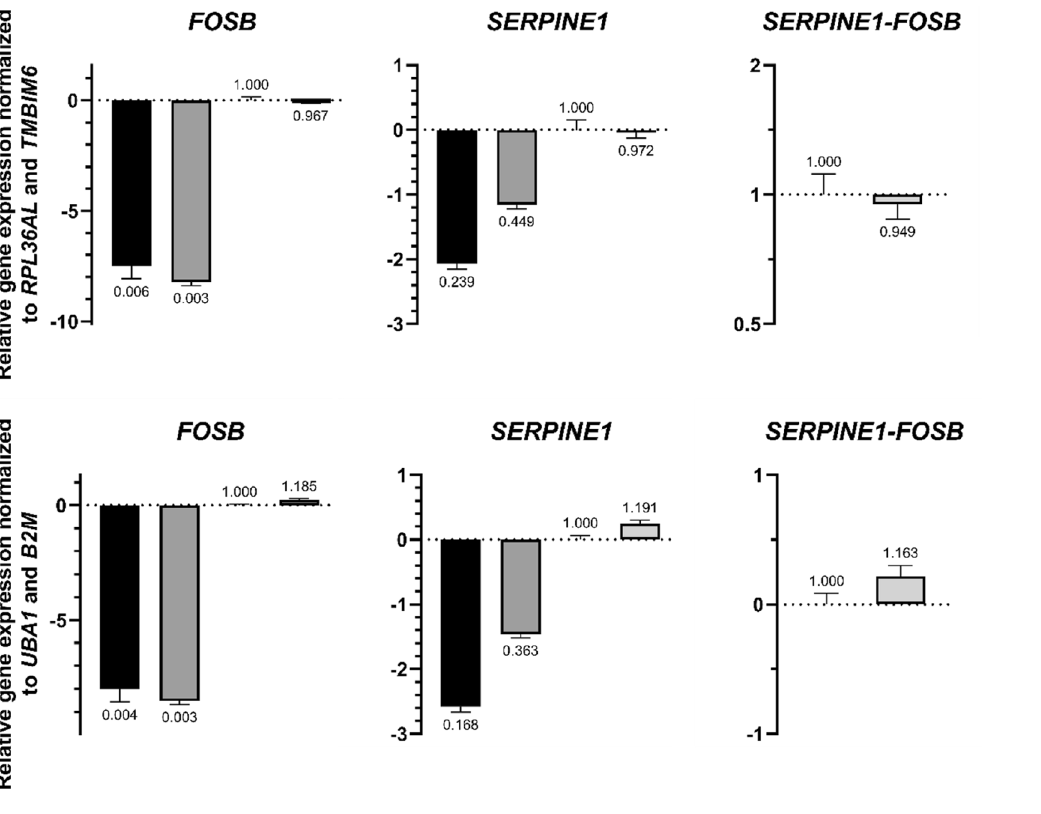
Figure 4. Gene expression of telatinib-treated cells. Relative to iPSC-EC SERPINE1-FOSB untreated, the log scale expression of FOSB , SERPINE1 or SERPINE1-FOSB were normalized to the top two, RPL36AL and TMBIMB , or bottom two, UBA1 and B2M , housekeeping genes of telatinib treated or untreated iPSC-EC WT and iPSC- EC SERPINE1-FOSB samples. Three biological samples of each treatment were pooled together and run qRT-PCR in technical